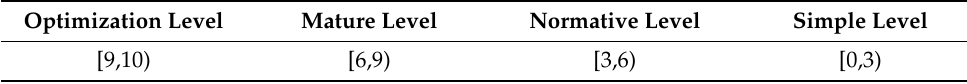
Table 5. Grey class classification level and score range.